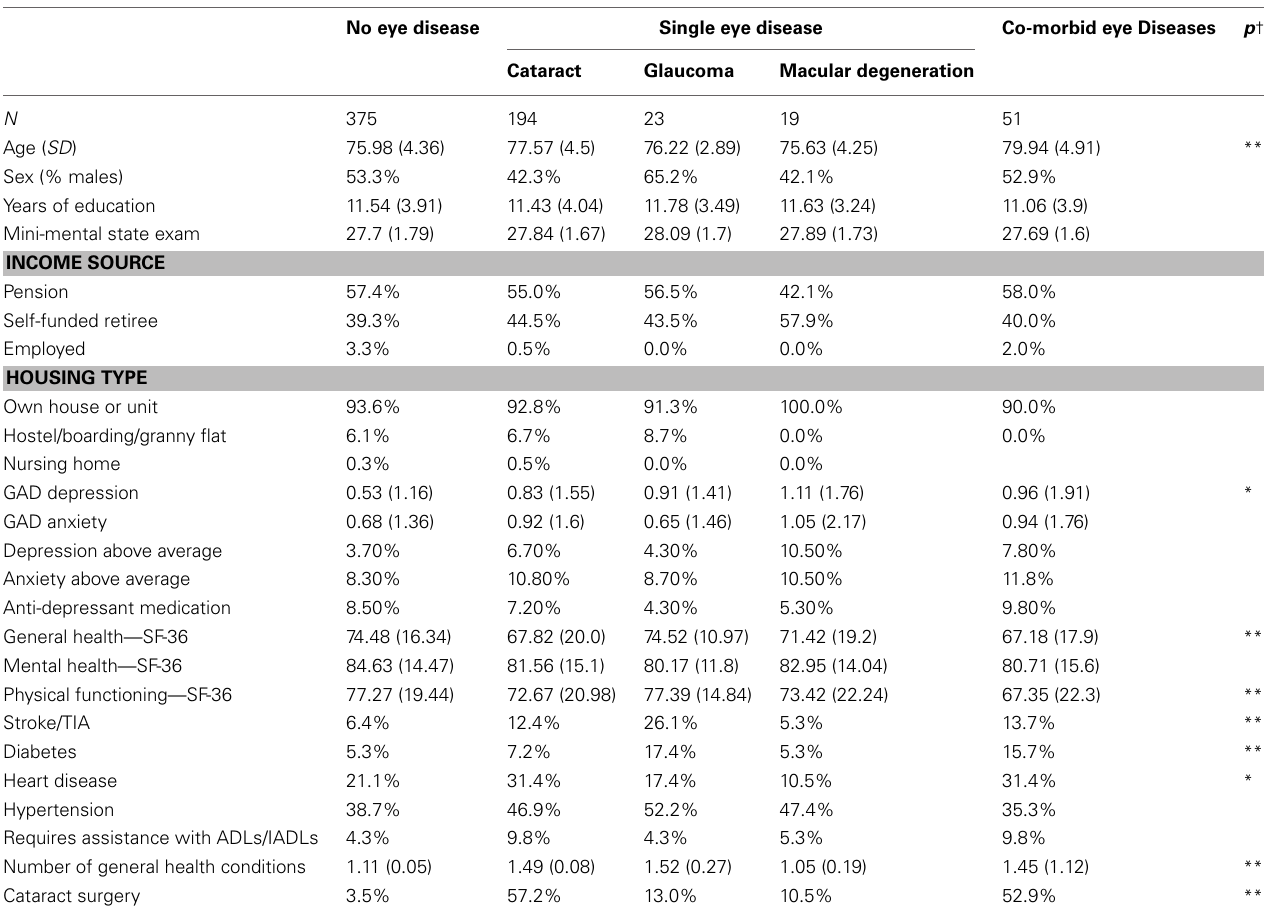
Table 1 | Demographic and health characteristics of the sample as a function of eye disease.